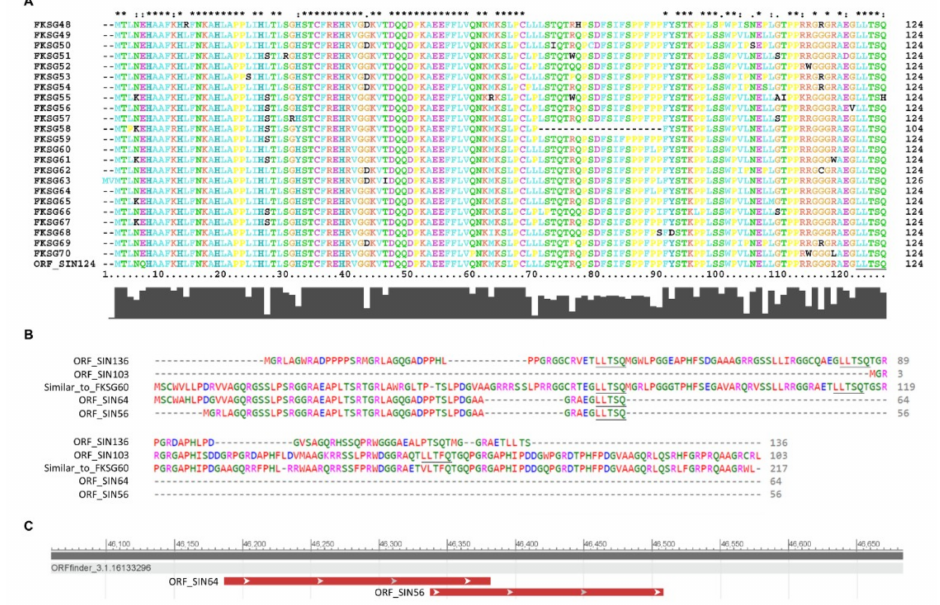
Figure 8. Sestrin-1 intron 1/2 serves as a source for production of “LLTSQ”-containing proteins: recognition of novel FKSG and FKSG-like superfamily members. ( A ) Multiple protein alignment of the herein identified ORF_SIN124 to the FKSG (48–70) protein family members (categorized by name), via utilization of the Clustal X2 bioinformatics program. Note the striking similarities in amino acid sequence among all compared proteins. ( B ) Multiple protein alignment, via engagement of the Clustal Omega bioinformatics platform, of the herein predicted, to be produced, ORF_SIN136, ORF_SIN103, ORF_SIN64, and ORF_SIN56 proteins, to the similar-toFKSG60 previously reported one. Remarkably, note the presence of “LLTSQ” (or, its variant version “LLTFQ”) pentapeptide (indicated by underlined fonts) not only in all five of them ( B ), but also in the new FKSG (FKSG71) member ORF_SIN124 ( A ). ( C ) Graphical presentation of the ORF_SIN64 and ORF_SIN56 coding territories, as they result from ORF Finder bioinformatics